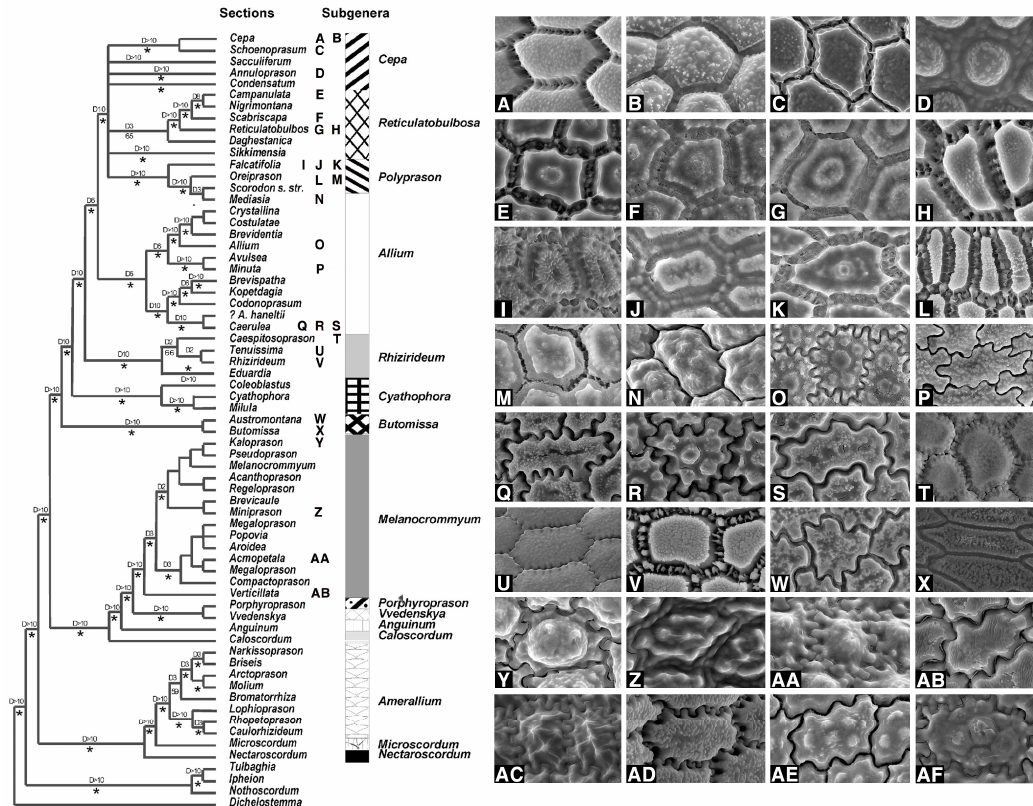
Figure 9. Seed testa characteristics of selected sections in Allium phylogeny tree (modified from Friesen et al., 2006). ( A – D ) subg. Cepa : ( A ) A. altaicum ; ( B ) A. oschaninii ; ( C ) A. maximowiczii